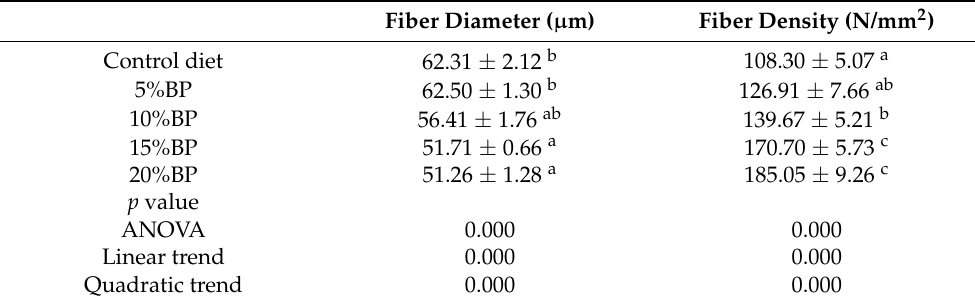
Table 8. Muscle fiber diameter and density in grass carp fed a diet with paper mulberry (BP) for 8 weeks.